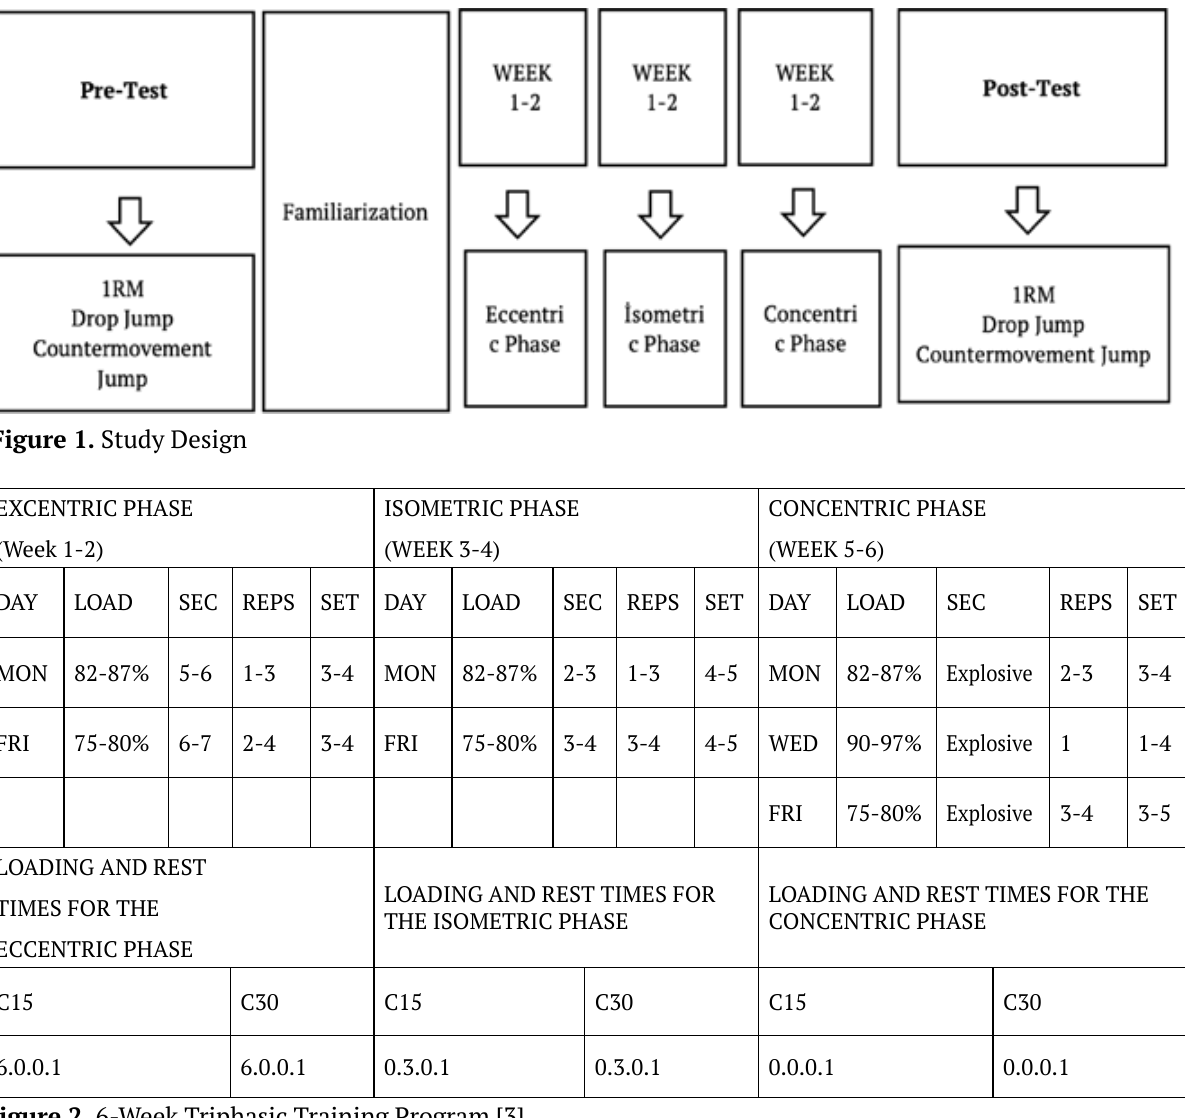
Figure 2. 6-Week Triphasic Training Program